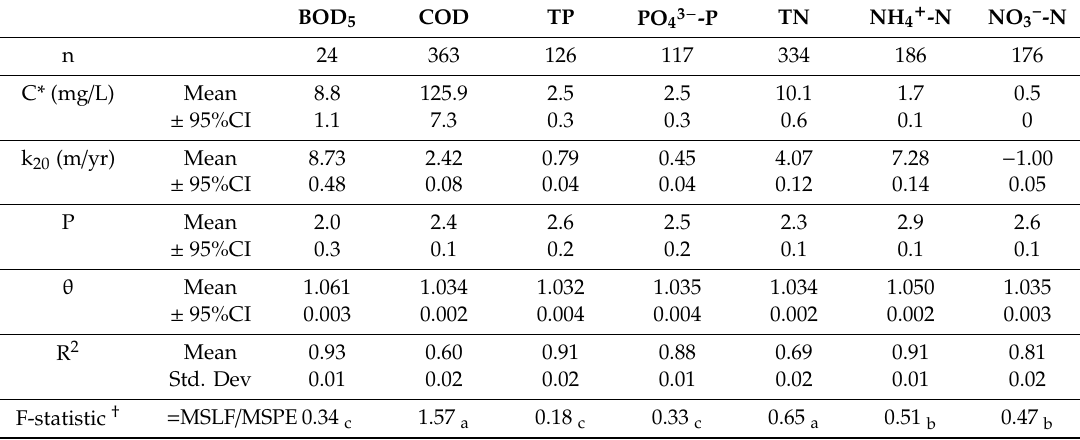
Table 4. Optimized P-k-C*model parameters and θ coe ffi cients for each water constituent. BOD 5